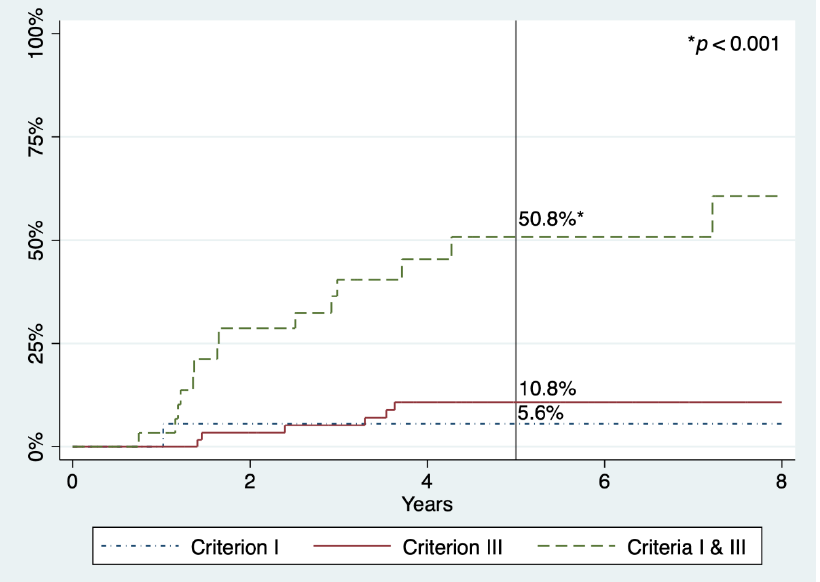
Figure 2. Cumulative incidences of advanced adenoma, advanced serrated polyp, and advanced neoplasia within follow-up in patients with SPS. Percentages refer to cumulative incidence at five years.